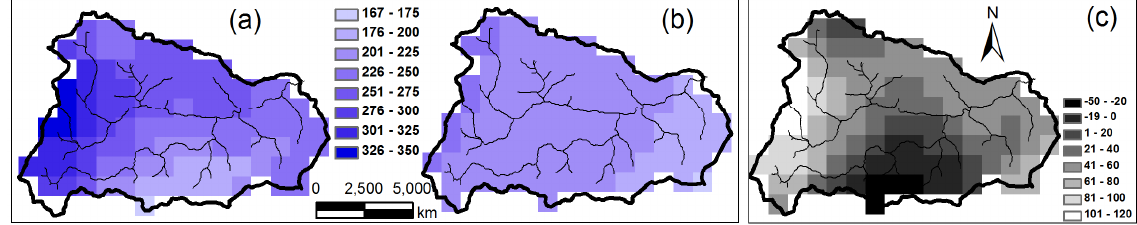
Fig. 7. Storm total rainfall (mm) for 18 September 2007 flood based on (a) radar observations, (b) interpolated raingauge measurements with a spatial resolution of 1km and (c) is the difference among (a) and (b) estimates. Figure 7: Storm total rainfall (mm) for the 18th September 2007 flood based on (a) radar 3 observations , (b) interpolated raingauge measurements with a spatial resolution of 1 km and 4 (c) is the difference among (a) and (b) estimates. 5